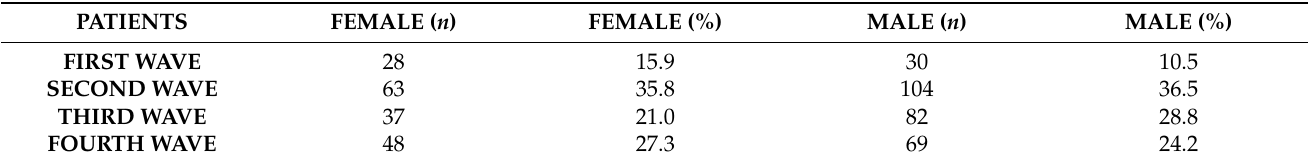
Table 1. Population sex